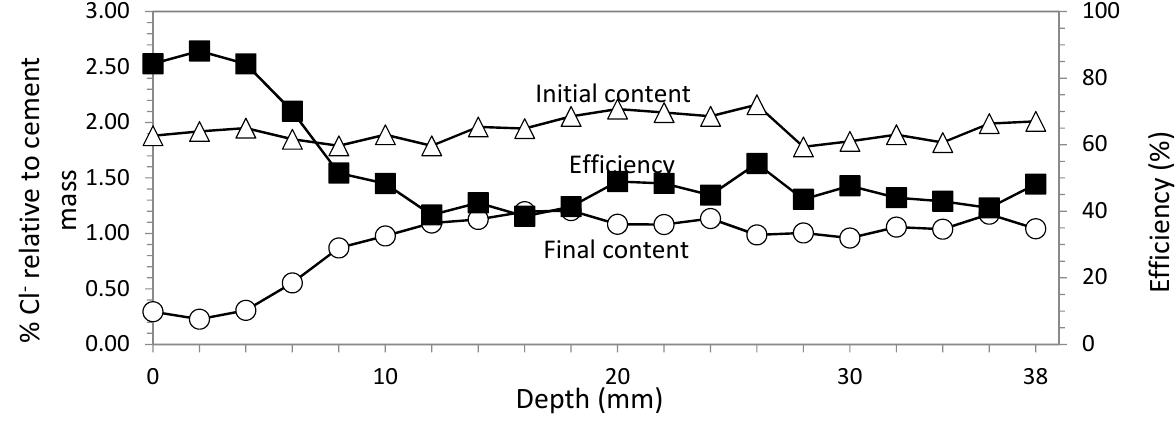
Figure 8. Study 3. Rectangular section specimens. ECE with Ti-RuO 2 mesh anodic system. Variable current density between 3–5 A/m 2 . Current charge density 5 × 10 6 C/m 2 . Contents of Cl − before and after ECE and differences in percentage relative to cement mass, which conform the efficiency profile. Core sample extracted in the center of the biggest face.